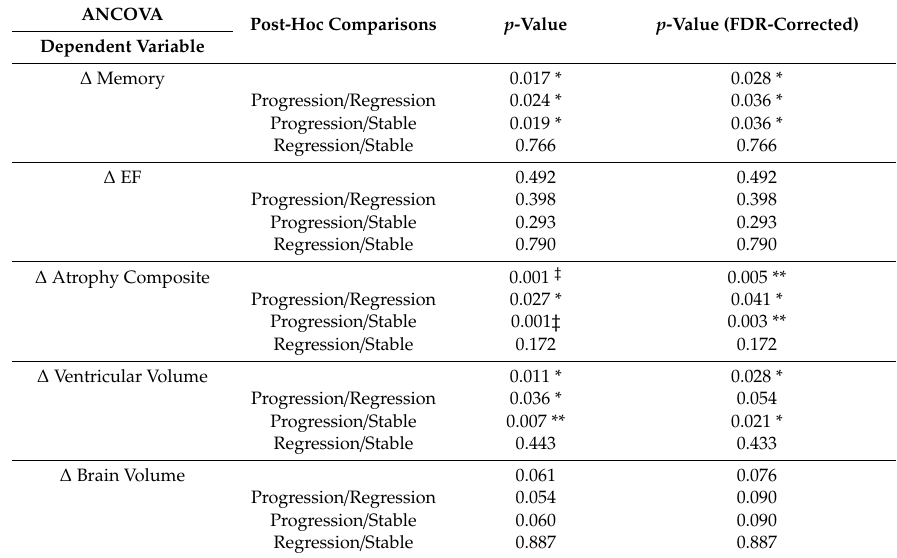
Table 3. ANCOVA results examining brain volume composite, memory change, and EF change in all three groups. Age and gender were used as